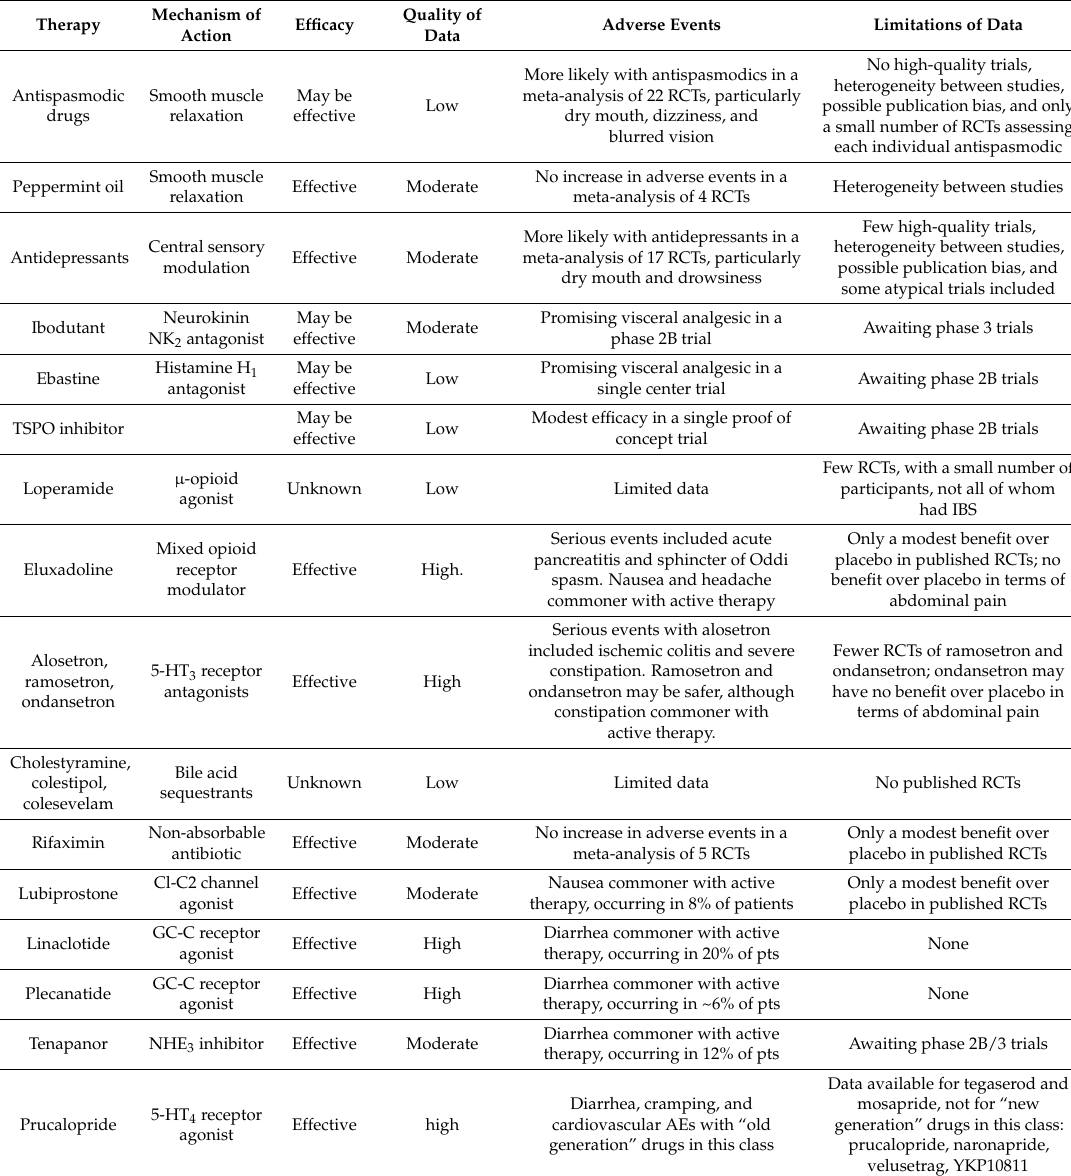
Table 1. Summary of current treatments and drugs in development for